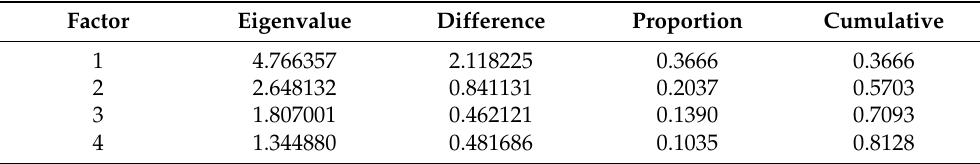
Table 4. The selected eigenvalues greater than one of PCA by database in 0–60 cm soil